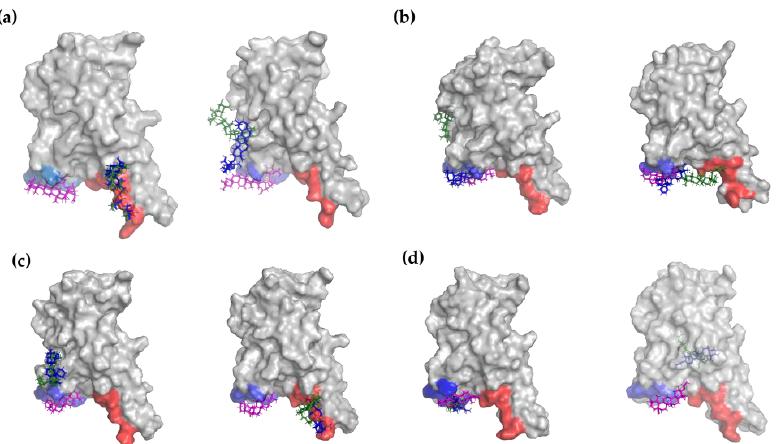
Figure 5. Ligand positions at 0 ns (magenta), 50 ns (blue) and 100 ns (green) of first (left) and second (right) replica of: ( a ) GA reference molecule, ( b ) OA5 , ( c ) MA4 and ( d ) UA2 derivatives. All diagrams were constructed with PyMOL. BS1 site is colored in red and BS2 in blue.